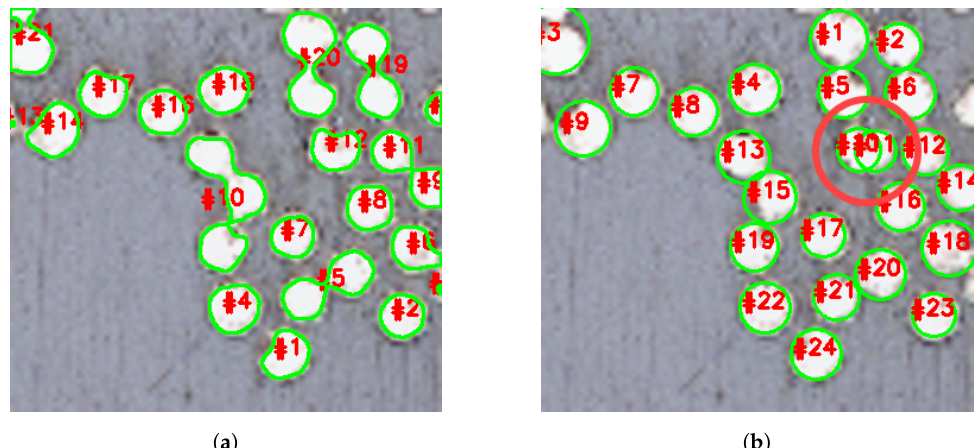
Figure 4. Contour definition of fibres with ( a ) and without ( b ) watershed algorithm